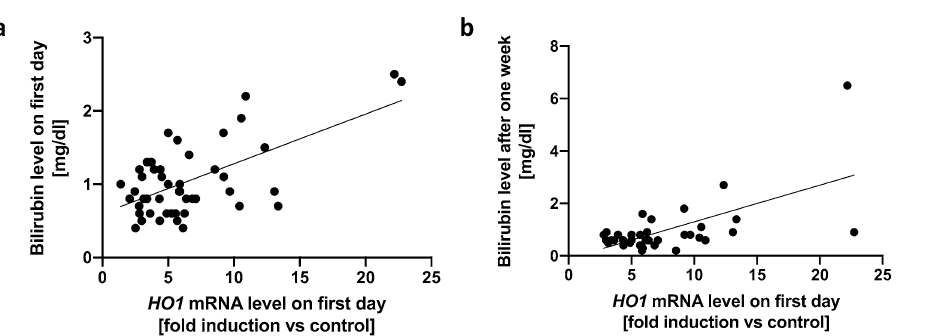
concentration at the same time missed significance (r = 0.253, P = 0.149, r 2 = 0.100, P < 0.067, data not shown). Biomarkers correlate with trauma severity and duration of ICU treatment. To review our hypotheses (Fig. 1a), the relationships between input variable and mediator as well as between mediator and output data were tested. Indeed, a higher ISS correlated with significantly higher mRNA expression levels of PER2 (r = 0.375, P = 0.009, r 2 = 0.166, P = 0.004, Fig. 3a) and HO1 (r = 0.603, P < 0.001, r 2 = 0.346, P < 0.001, Fig. 3b), and among each other, (r = 0.424, P = 0.003, r 2 = 0.144, P = 0.008, data not shown). Similarly, higher